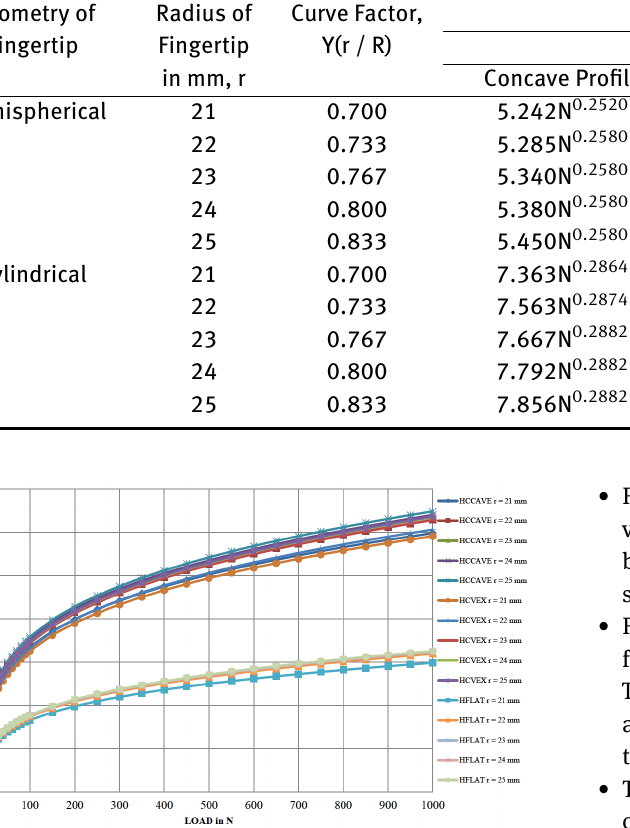
Table 2: Fitted Power Law Equations for Flat and Non Flat Profiles Geometry of